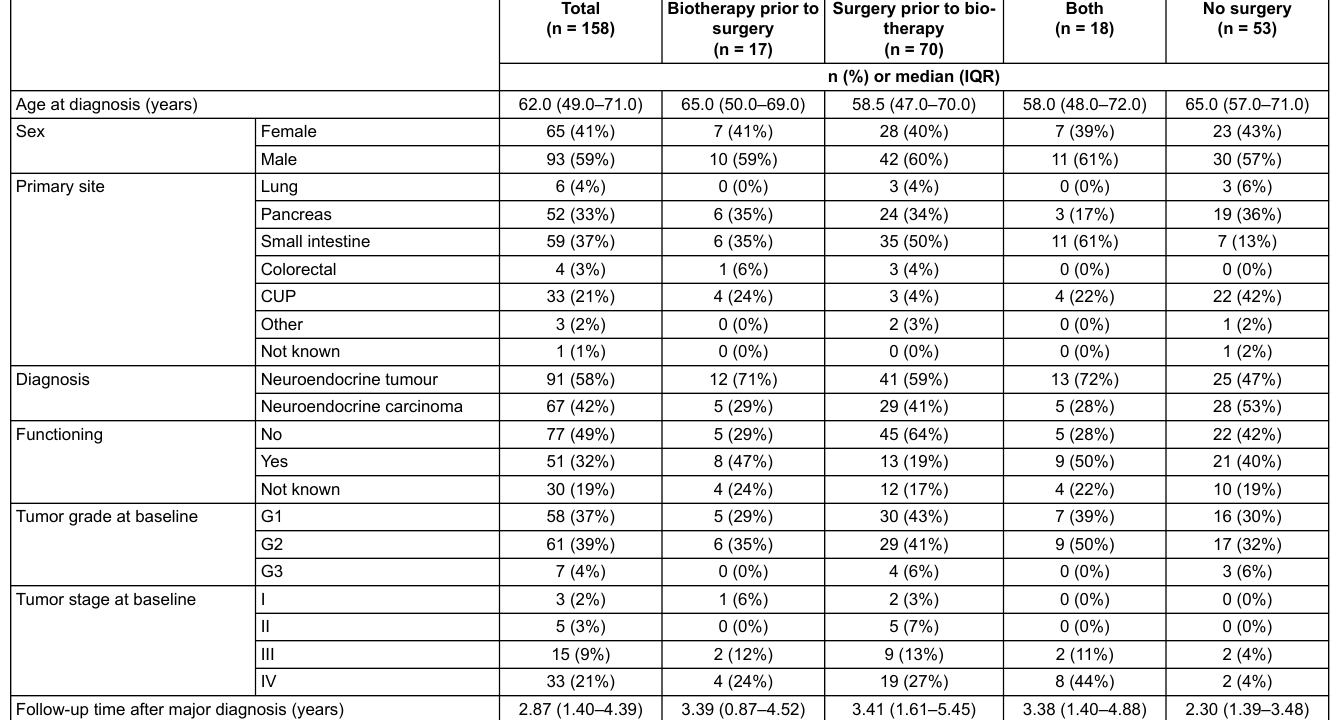
Table S1: Patient characteristics according to biotherapy sequence